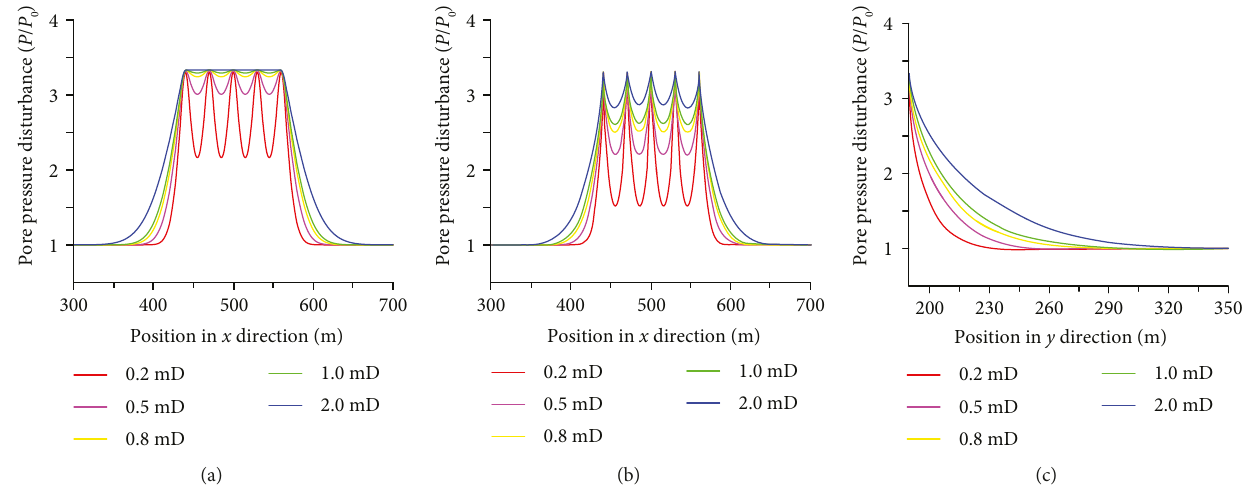
Figure 3: The pore pressure distributions at di ff erent times from the modelling ( k = 0 2 mD, μ = 1 mPa · s, P (a) t = 1 h, (b) t = 2 h, (c) t = 3 h, and (d) t = 4